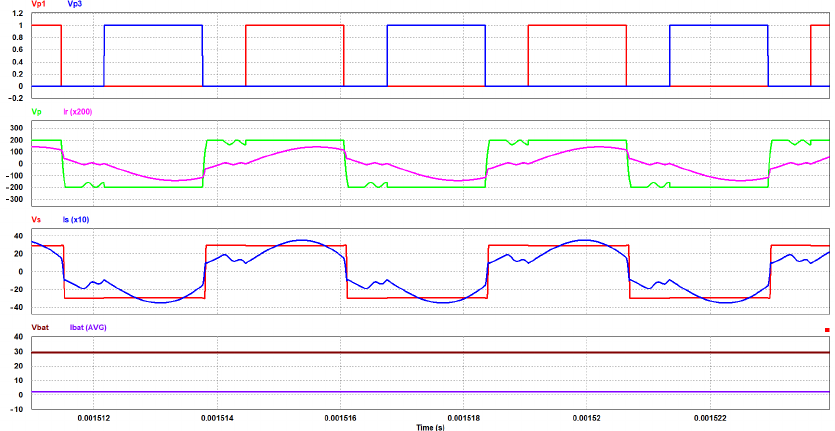
Figure 15. LLC resonant converter S-PWM simulation V o = 29.4 V, I o = 2.3 A, f sw = 218 kHz, 75% S-PWM duty.